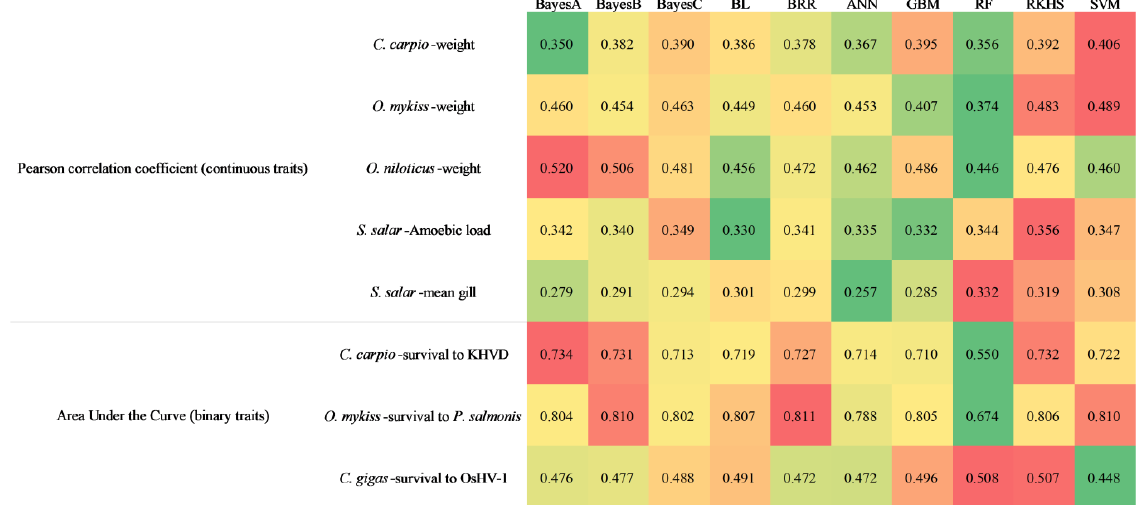
Figure 2. Prediction accuracy of each algorithm when noisy data is added to the phenotype. The O. niloticus weight-trait dataset was used. The percentage of noisy data included in the phenotype data and the prediction efficiency evaluated by Pearson correlation coefficient are represented in the X and Y axes, respectively.